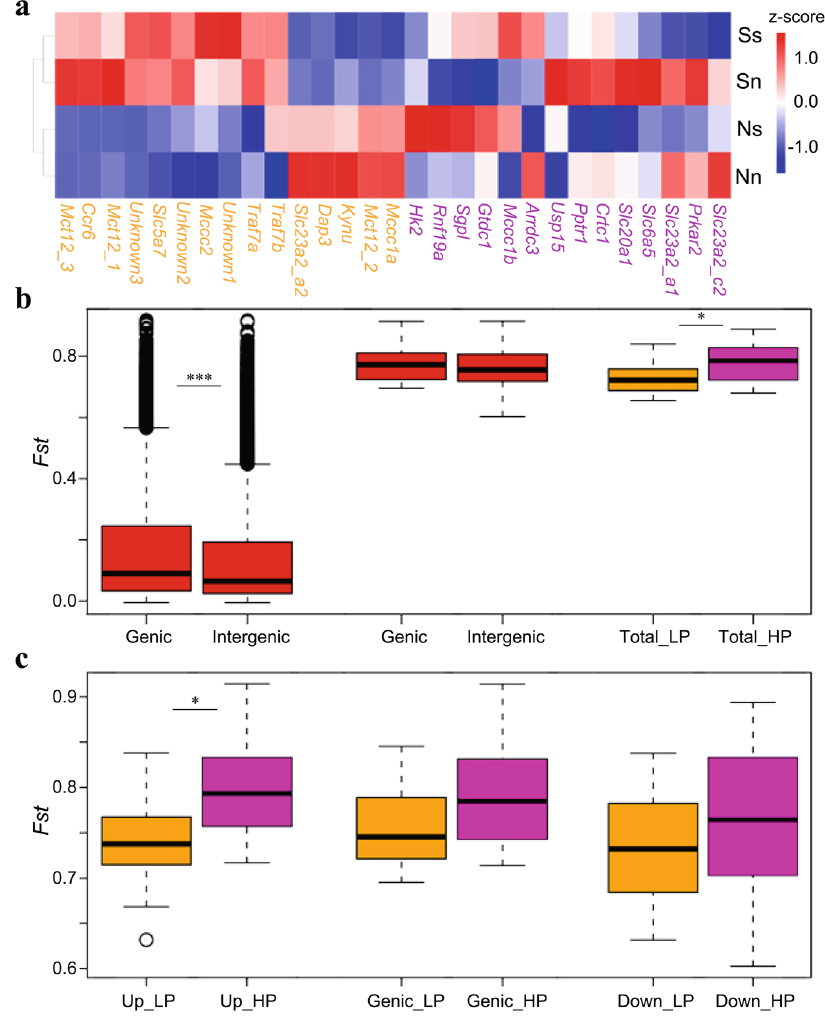
Fig. 5 Transcriptional and genomic divergence of genes with selection signals in the estuarine oyster. a Expression level of genes under selection in northern (N) and southern (S) populations (capital letters) acclimated to northern (n) and southern (s) environments (lowercase letters), showing low plasticity (LP, orange) and high plasticity (HP, purple) genes. The blue-to-red color bar represents the relative expression level of the given gene from low to high. b Genetic divergence ( F ST ) for genic and intergenic regions at genome level (left) and for 29 genes under selection (middle), and for LP and HP genes in both genic and intergenic regions (Total, right). c Genetic divergence ( F ST ) for intergenic [Up: upstream (left) and Down: downstream (right)] and genic (middle) regions of LP and HP genes. Asterisks indicate signi fi cant difference (* p < 0.05, *** p < 0.001). The data are presented as box plots; the central rectangle spans the fi rst to third quartiles of the distribution, and the ‘ whiskers ’ above and below the box show the maximum and minimum estimates. The line inside the rectangle shows the median, the circles represent